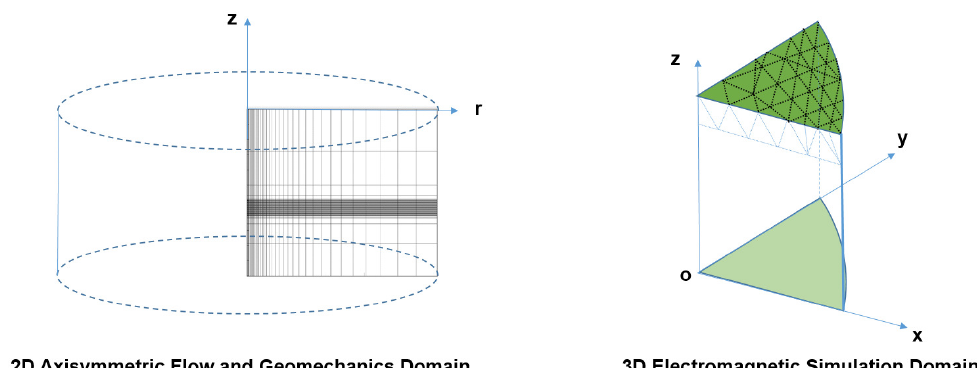
Figure 2. Numerical domains for the integrated coupled flow-geomechanics-EM simulation: ( left ) 2D axisymmetric domain with quadrilateral meshes for coupled flow and geomechanics and ( right ) 3D Cartesian domain with tetrahedral meshes converted for the EM simulation.